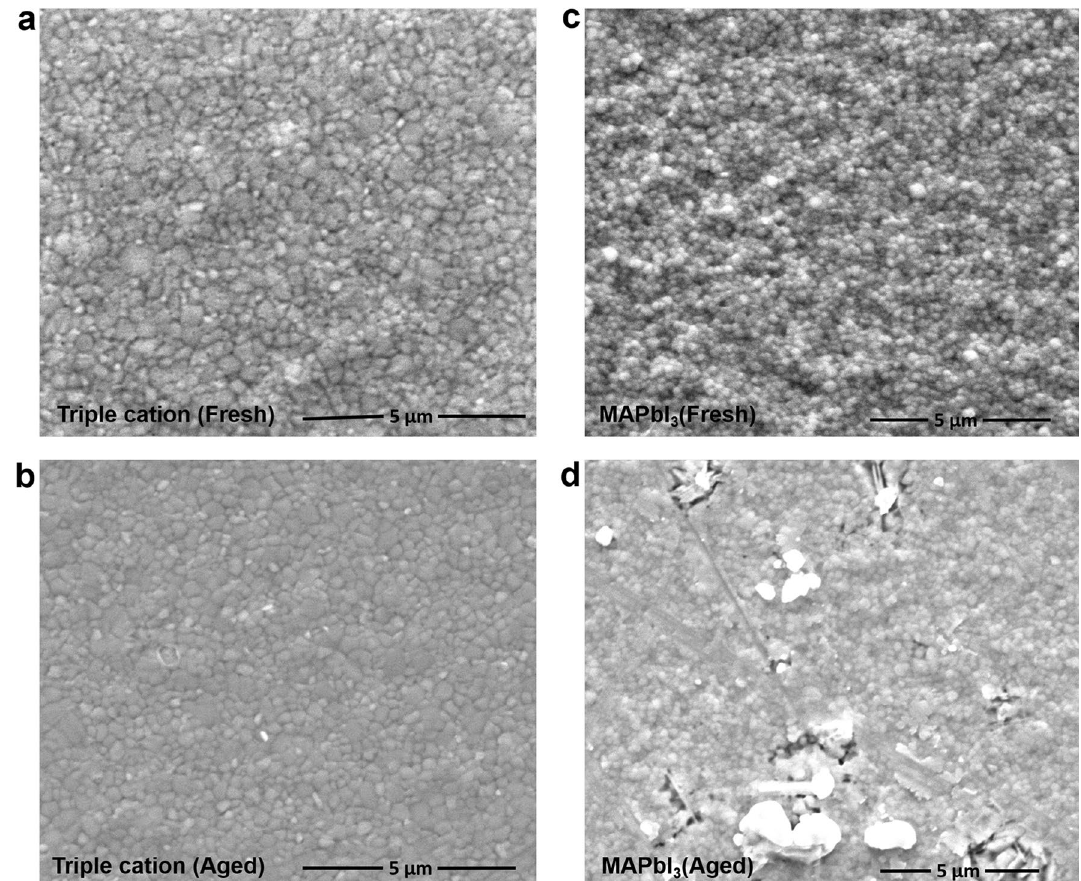
Figure 4. SEM images of ( a ) fresh and ( b ) aged triple cation perovskite absorber on FTO/TiO 2 . The exposure to ambient conditions included 10 days of storage in a petri dish/at 25 °C and RH ~ 30 to 40%. SEM images of ( c ) fresh and ( d ) aged MAPbI 3 perovskite absorber on FTO/TiO 2 . The fresh and aged triple cation appeared to be more dense compared to the MAPbI 3 whose porosity increased with aging leading to potential avenues for nucleating degradation